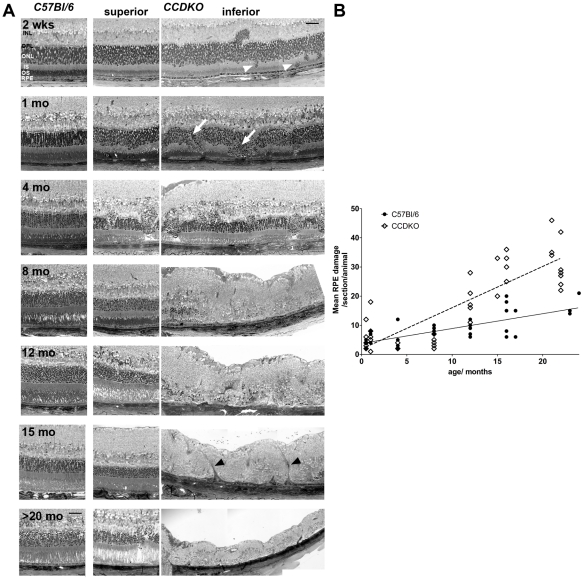
The primary degenerative event in the course of the degeneration is located in the outer nuclear layer of CCDKO mice and leads to the secondary development of RPE damage.(A) Superior-inferior oriented sagittal semithin histology of the outer retina of CCDKO mice and age-matched C57Bl/6 wildtype mice at the level of the optic disc between 2 weeks and over 20 months of age. A localized drop-out of nuclei from the ONL (white arrowheads) as early as 2 weeks of age in CCDKO mice suggests a primary pathological event in the retina that initiates the progressive inferior retinal degeneration in this model finally leading to the complete loss of retinal layers from 8 months of age onwards. The RPE underneath these lesions is secondarily affected. White arrows: drop out of photoreceptor columns, black arrowheads: descending retinal vessels, INL: inner nuclear layer, OPL: outer plexiform layer, ONL: outer nuclear layer, IS: inner segments, OS: outer segments, RPE: retinal pigment epithelium. (B) Quantitative morphometry of RPE damage on the same sections. We observed an normal age-related increase of RPE damage in wildtype mice (C57Bl/6: Pearson r2 = 0.5562, p<0.0001, N = 37) and observed that the age-related increase of RPE damage in CDDKO mice (CCDKO: Pearson r2 = 0.7115, p<0.0001; N = 43) was significantly higher compared to C57Bl/6 mice (linear regression analysis, p<0.0001),which was significantly more pronounced in CCDKO mice (Pearson r2 = 0.465,p = 0.0007; slope difference: p = 0.01). Nevertheless the RPE damage becomes only significantly higher during late stages of the degeneration suggesting a secondary involvement of the RPE during the degenerative process. Scale bars: 25 µm.